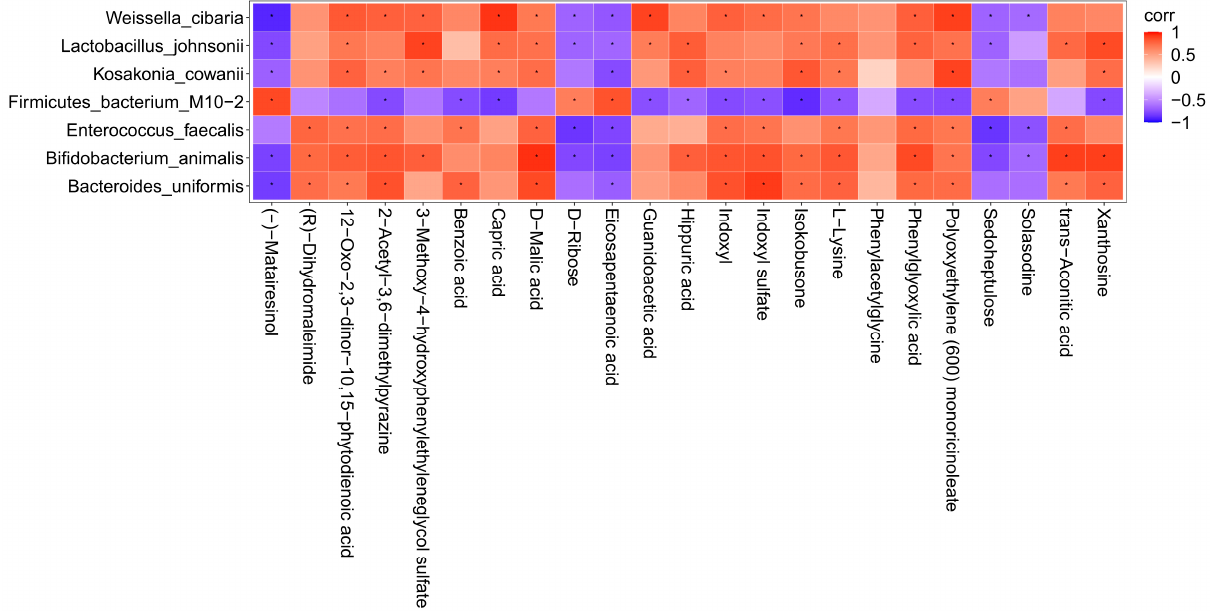
Figure 5. Correlation analysis between characteristic bacteria and metabolites. corr = correlation. Red represents positive correlation and blue represents negative correlation. The deeper the color, the greater the correlation. * indicates p <